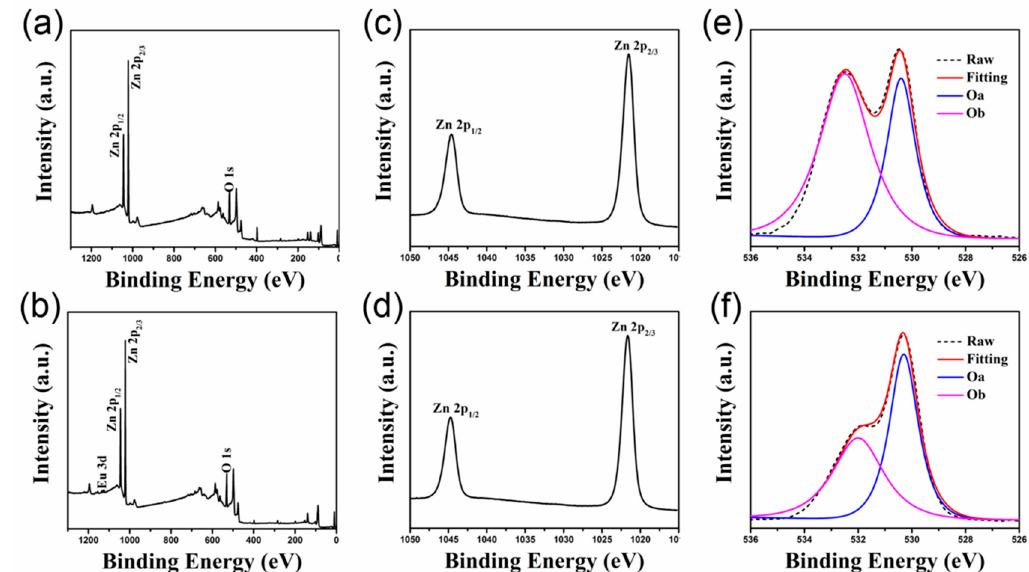
Figure 2. X-ray photoelectron spectroscopy (XPS) spectra of ZnO and ZnO / ETP films ( a , b ) survey scan, ( c , d ) Zn 2p spectra, and ( e , f ) O 1s spectra of ZnO and ZnO / ETP films.